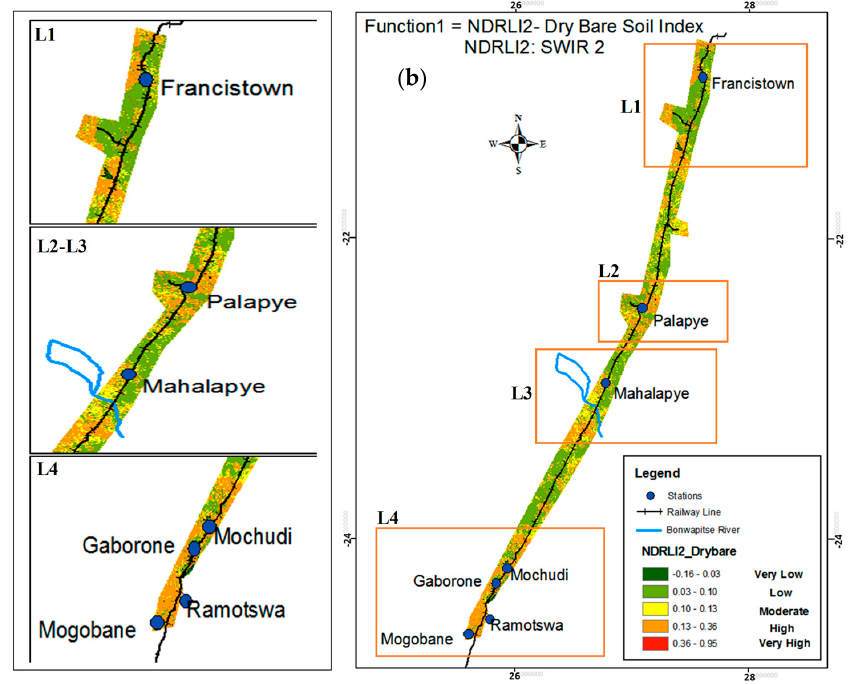
Figure 10. ( a ) NDReLI1 for BRC based on SWIR1. ( b ) NDReLI2 for BRC based on SWIR2.